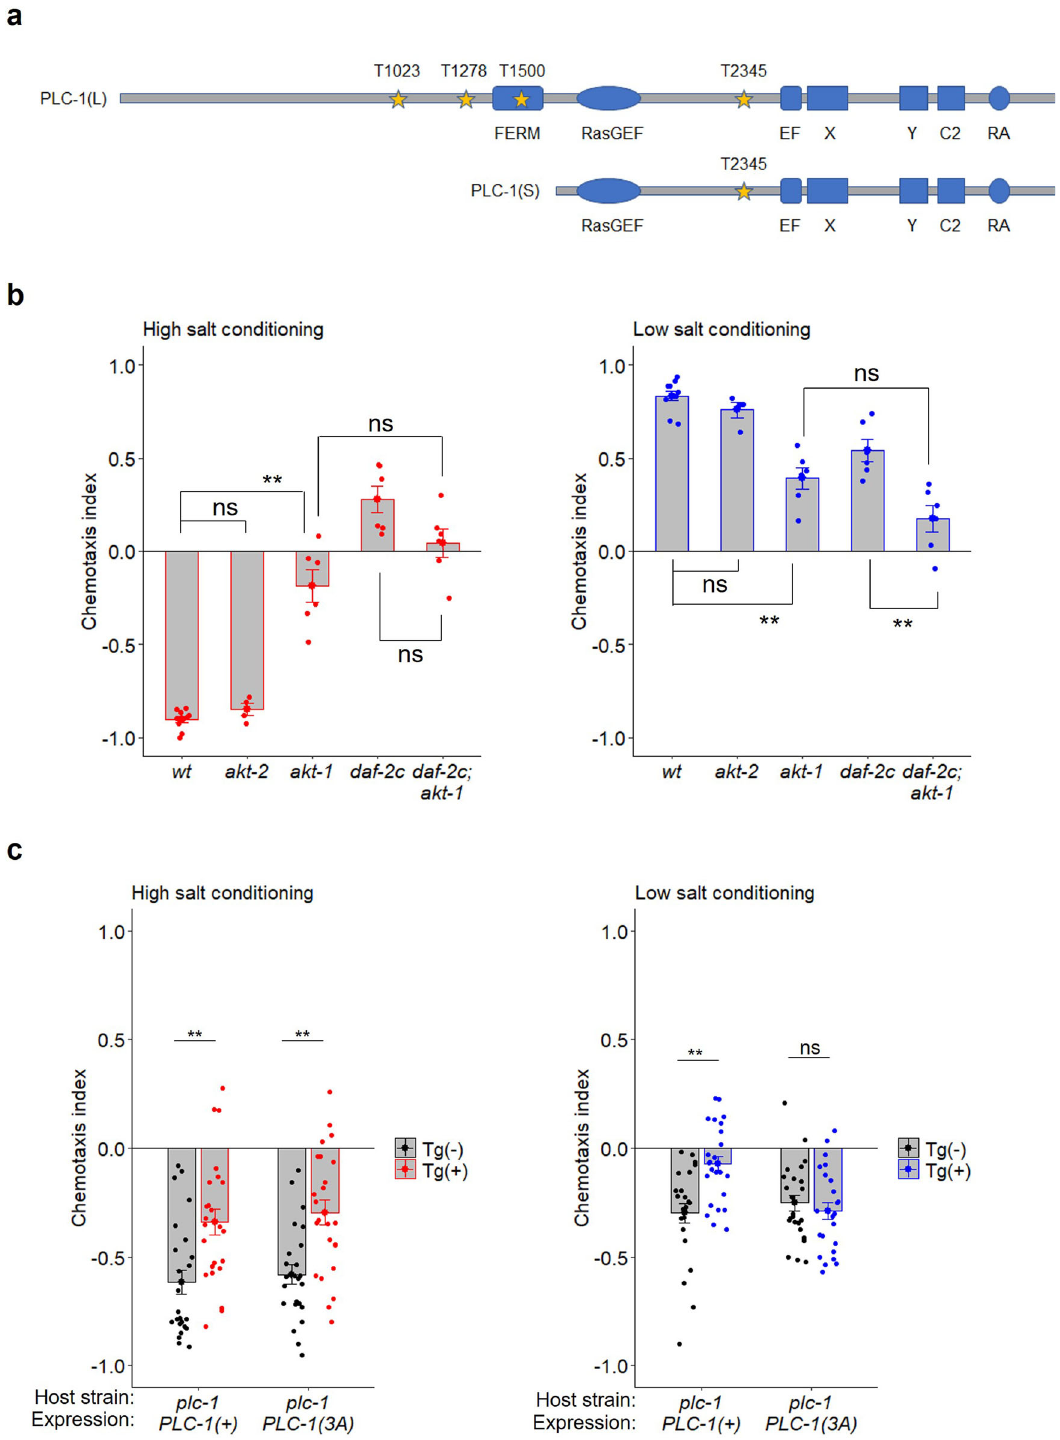
Fig. 6 Putative Akt phosphorylation sites of PLC-1(L) are required for high-salt migration after starvation conditioning at low salt. a The domain structures of PLC-1(L) and PLC-1(S) were analyzed with Pfam 33.1 (http://pfam.xfam.org/). Threonine residues in the Akt phosphorylation consensus sites (RXRXXT) are highlighted with yellow stars. Genetic interactions between Akt and daf-2c mutations ( b , n = 4 – 10 assays) and rescue of taste avoidance learning by PLC-1( + ) or PLC-1(3A) in the plc-1(pe1238) mutant ( c , n = 24 assays). Chemotaxis indices after high- or low-salt conditioning in the absence of food. Each dot in red or blue represents a value calculated in each chemotaxis assay after conditioning at high or low salt concentrations, respectively. A black dot represents a chemotaxis index calculated in each chemotaxis assay using worms without transgenes. Bars represent mean values; error bars represent SEM. Two-tailed Welch ’ s t-test with Holm correction: ** P < 0.01. ns not signi fi cant.